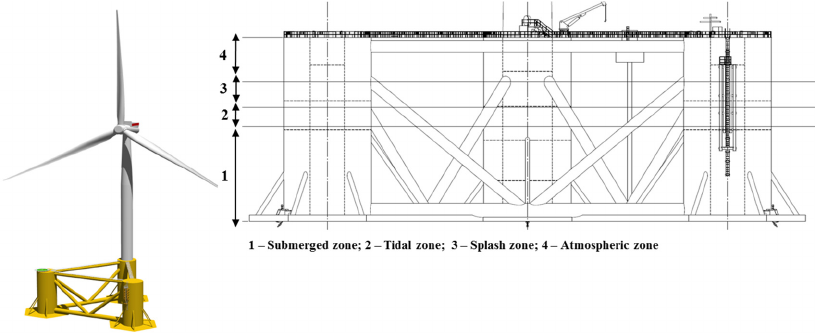
Figure 1. Structure and corrosion zones of Offshore WindFloat platform. Courtesy of PPI, Principle Power Inc. (Emeryville, CA, USA).